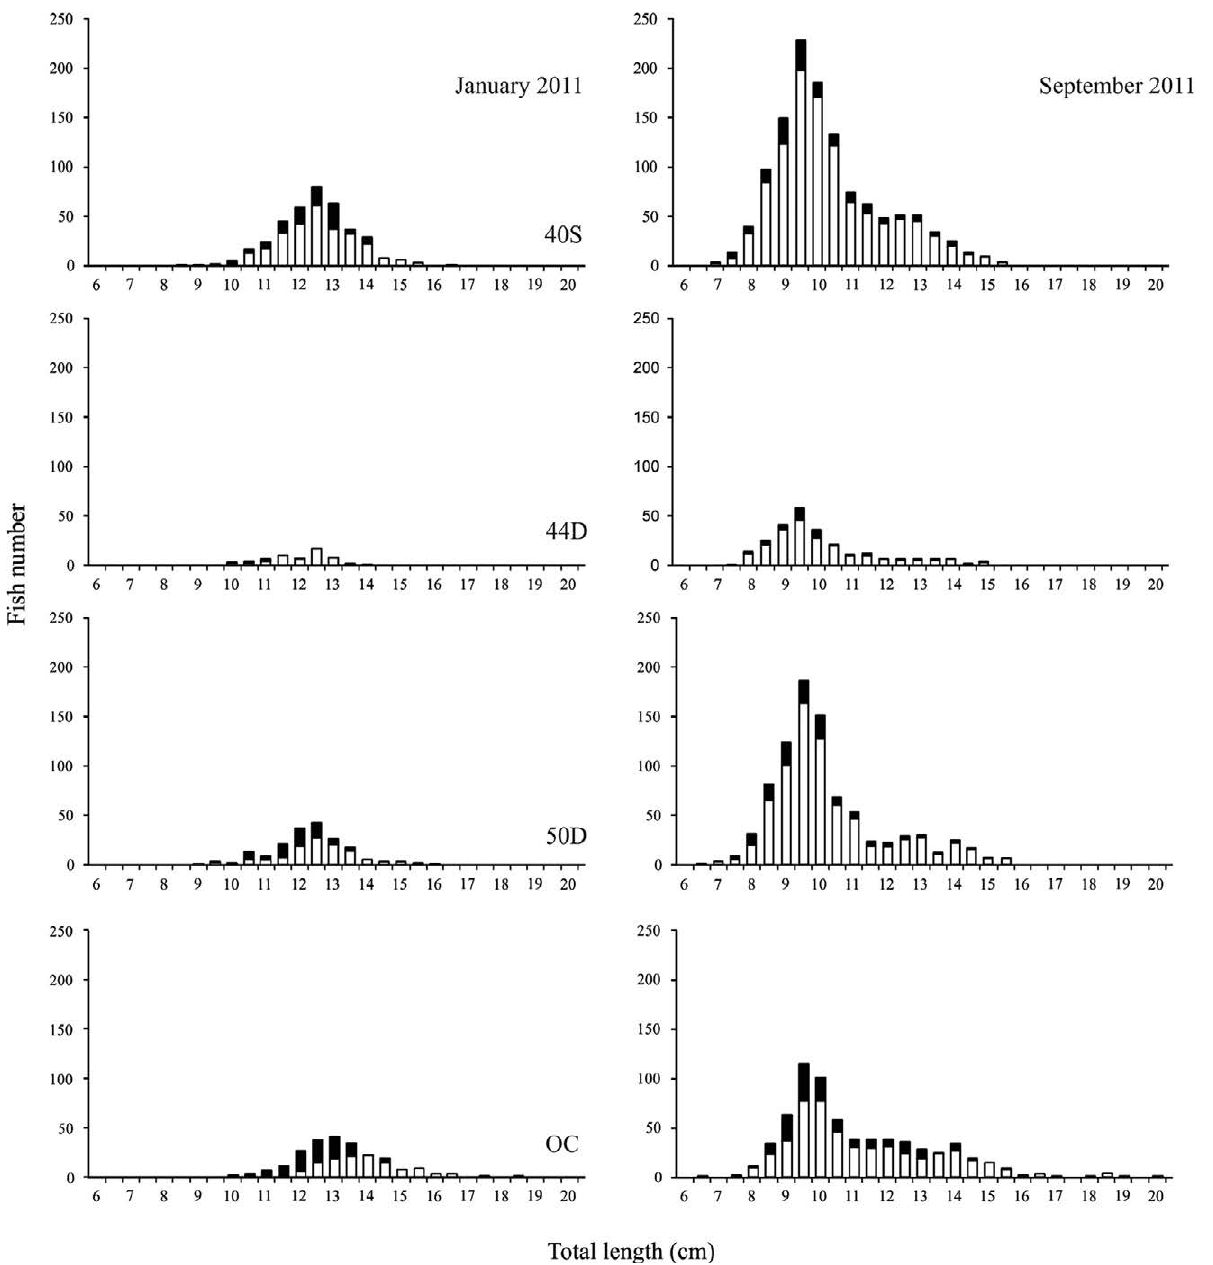
Fig. 3. – Red mullet. Number of dead fish (black) and survivors (white) in each length class for test and open codend cages in winter and summer of